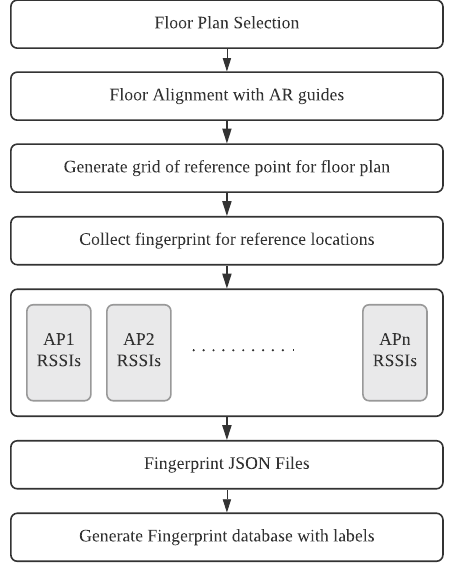
Figure 2. Framework for floor plan alignment and